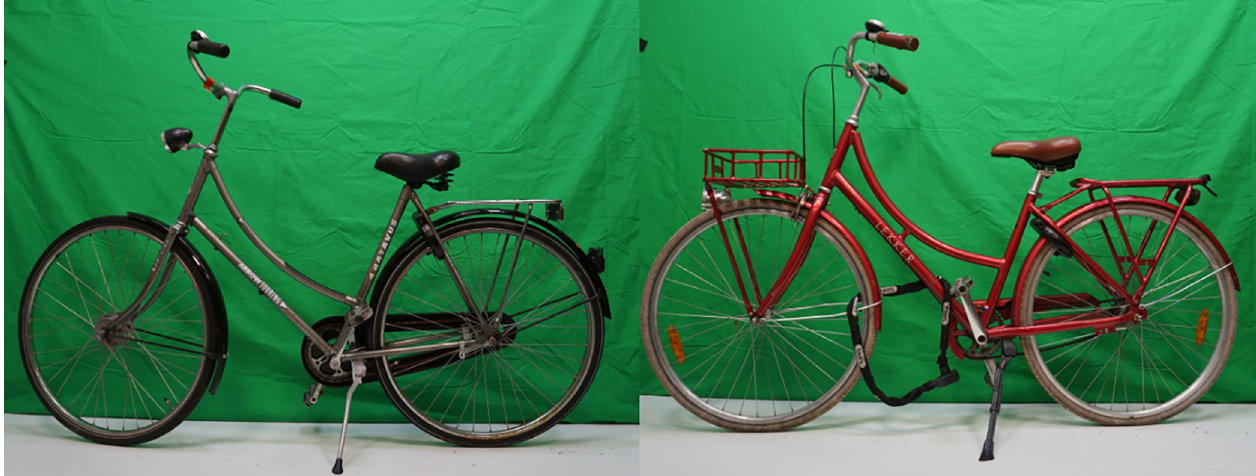
Fig 4. Two of the bikes used in the study, on the right an older model Batavus, on the left a newer bike from the brand